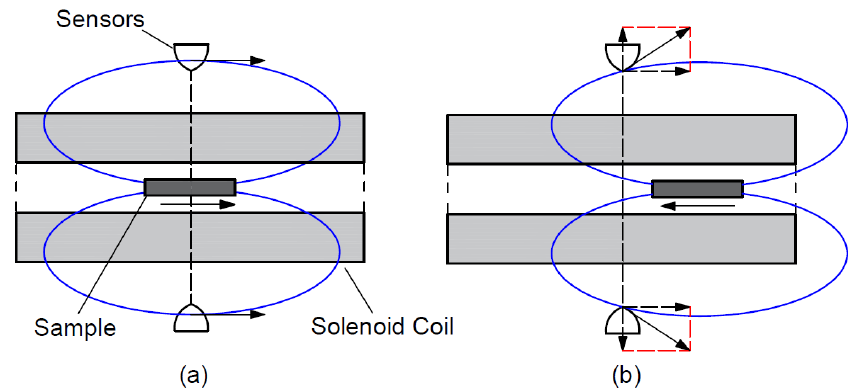
Figure 14. Set-up of the Foerster-type DC coercimeter: ( a ) First step of the measuring; ( b ) second step of the measuring.